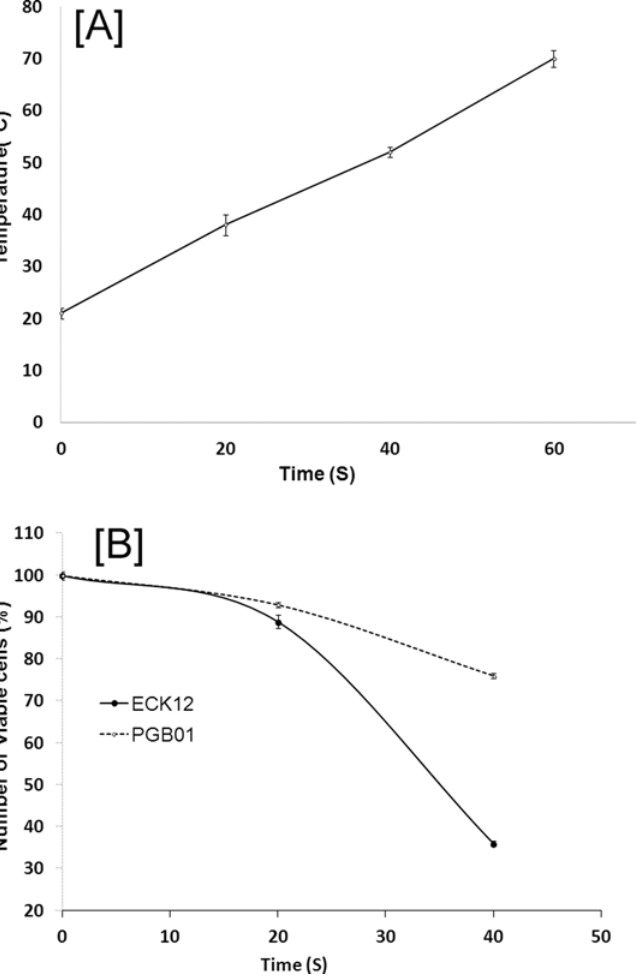
Fig 2. Effect of microwave radiation on cell viability. A. Thermal effect of microwave radiation: Temperature of LB vs. time of exposure; B. Viability of cells vs. time of microwave exposure.